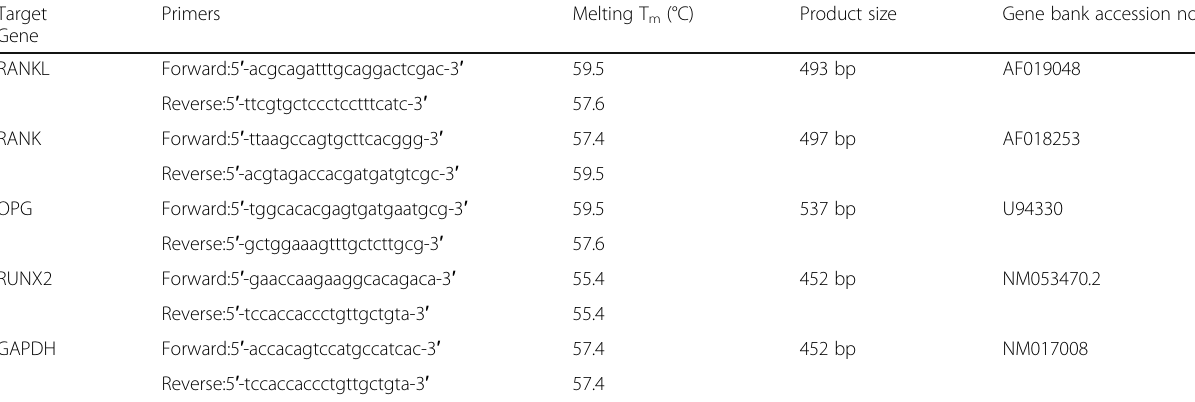
Table 1 The primer sequences, melting temperature, their respective product size, and gene bank accession